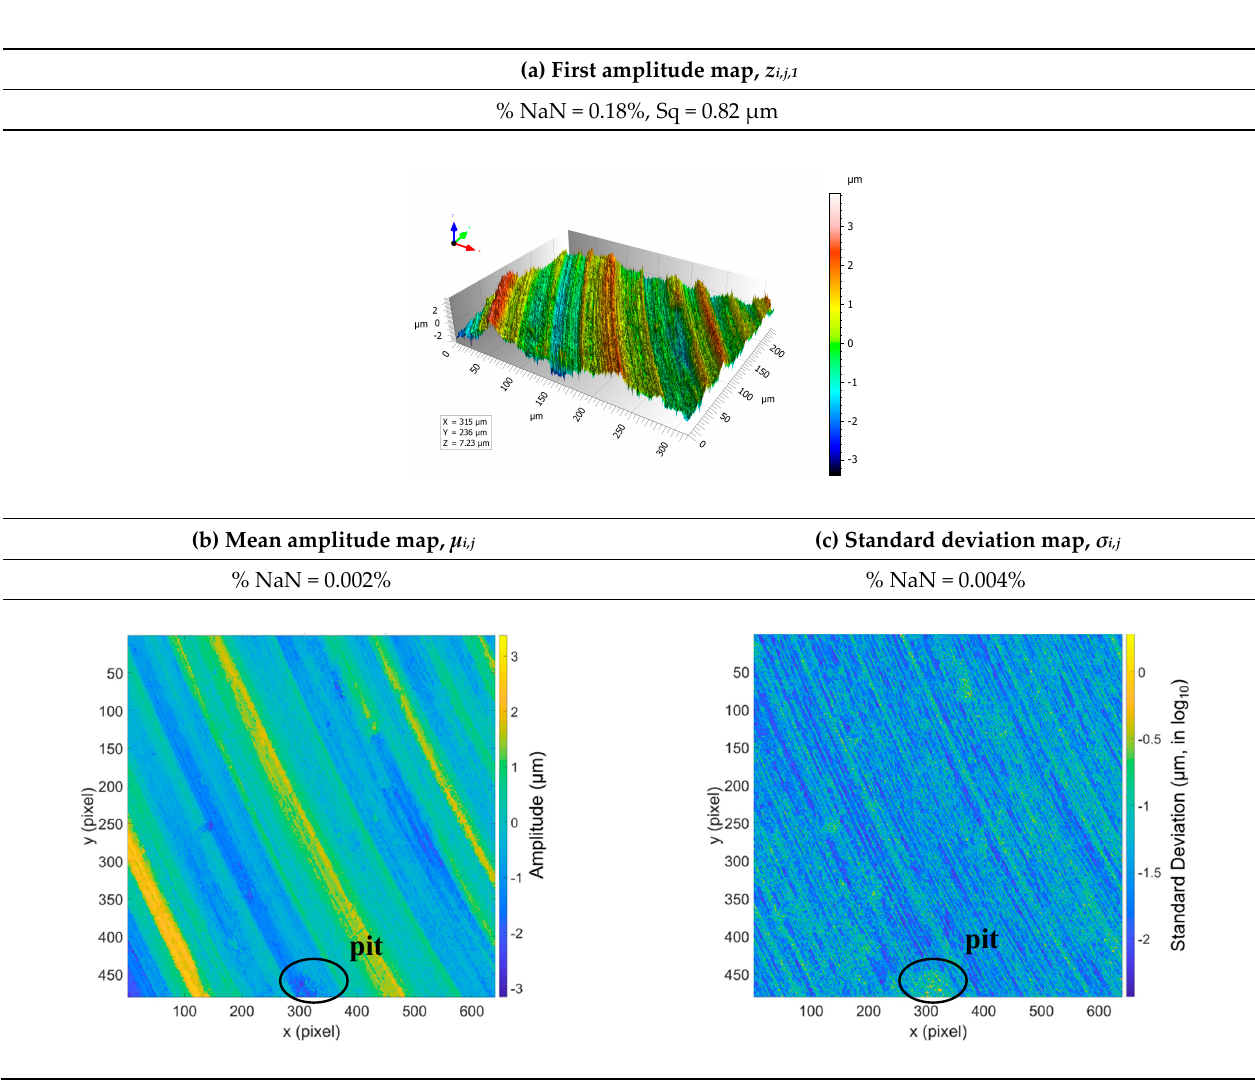
Figure 5. First elementary map of the turned surface ( a ), as well as a mean amplitude map ( b ) and a standard deviation map ( c ) calculated from the set of 100 elementary maps.